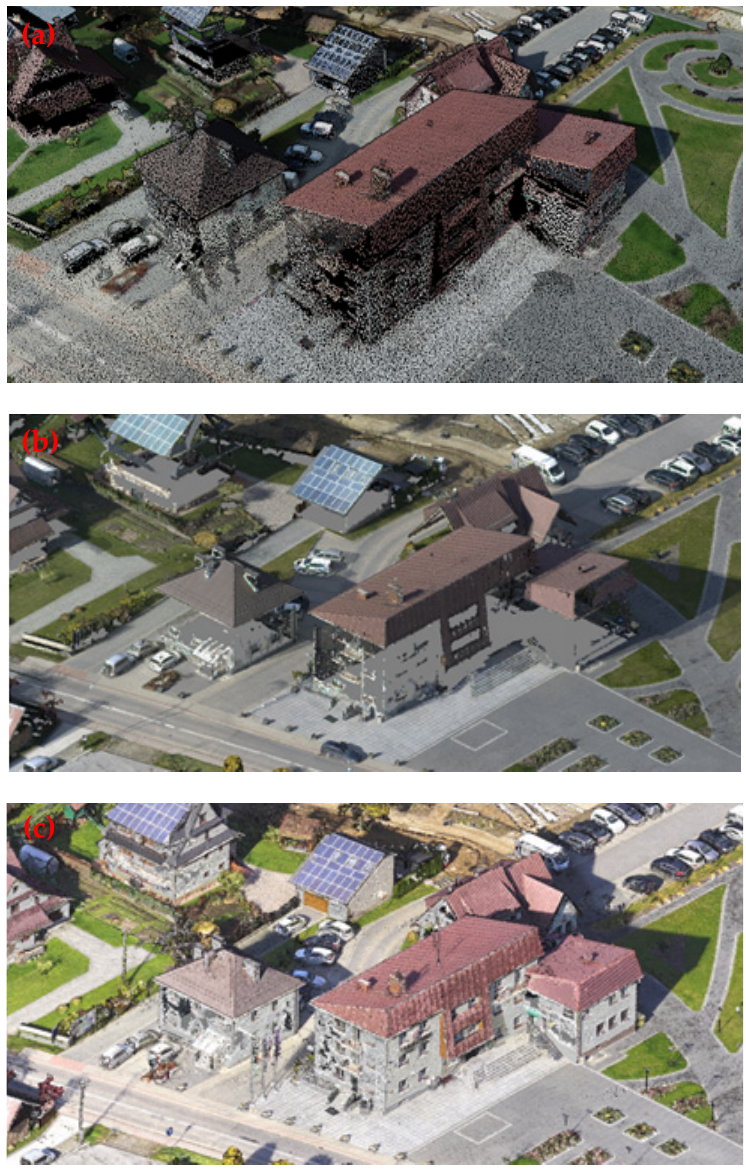
Figure 10. Completeness of geometric data for surfaces with a large inclination ( a ) L1 laser scanner ( b ) P1 camera ( c ) PSDK camera.